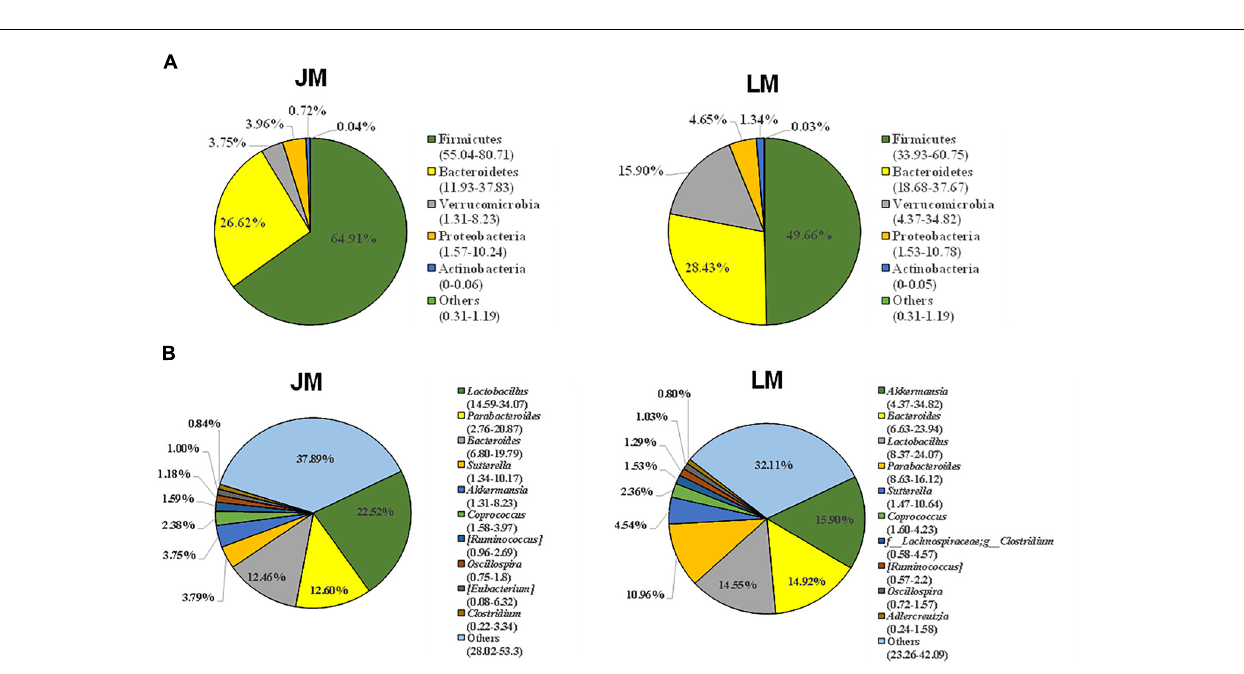
FIGURE 5 | Cecal bacterial community structure of mouse recipients at the phylum (A) and genus (B) levels. Only top 5 phyla and top 10 genera are shown. JM, mice receiving fecal microbiota from Jinhua pigs; LM, mice receiving fecal microbiota from Landrace pigs.